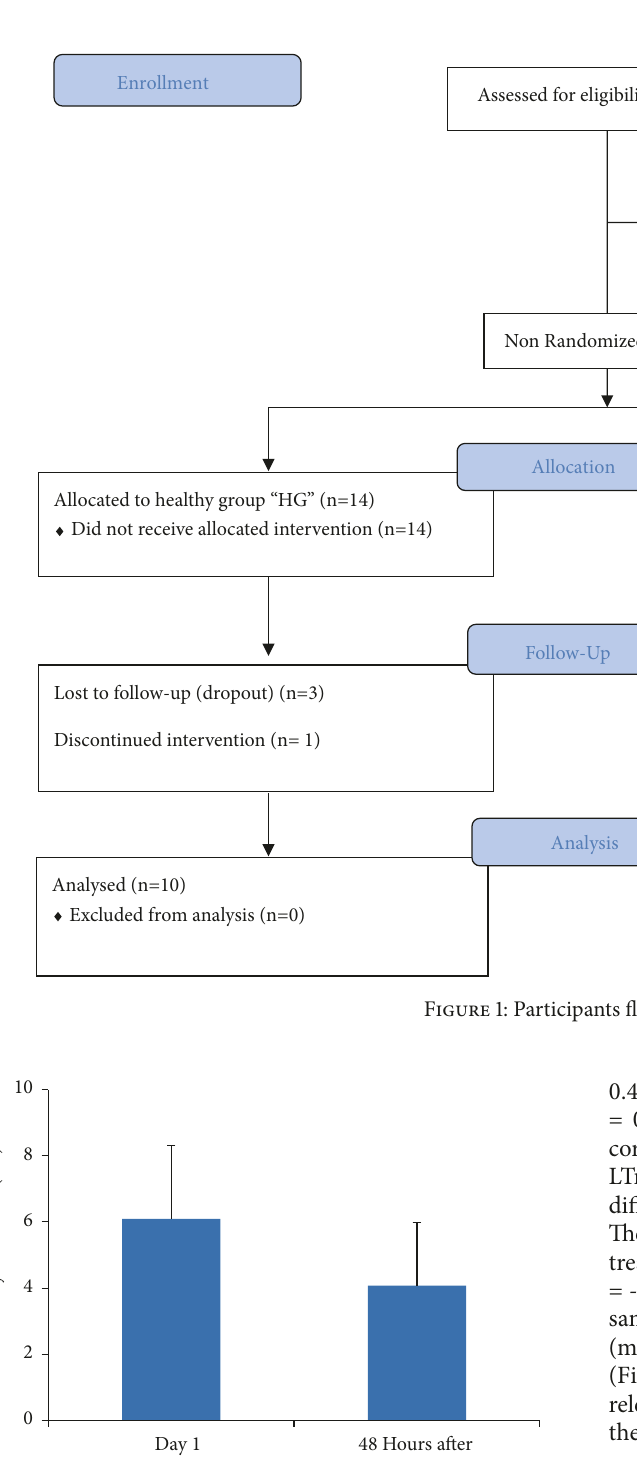
Figure 2: Mean and standard deviation differences in the PG’s subjective pain perception before and after the treatment ( p <